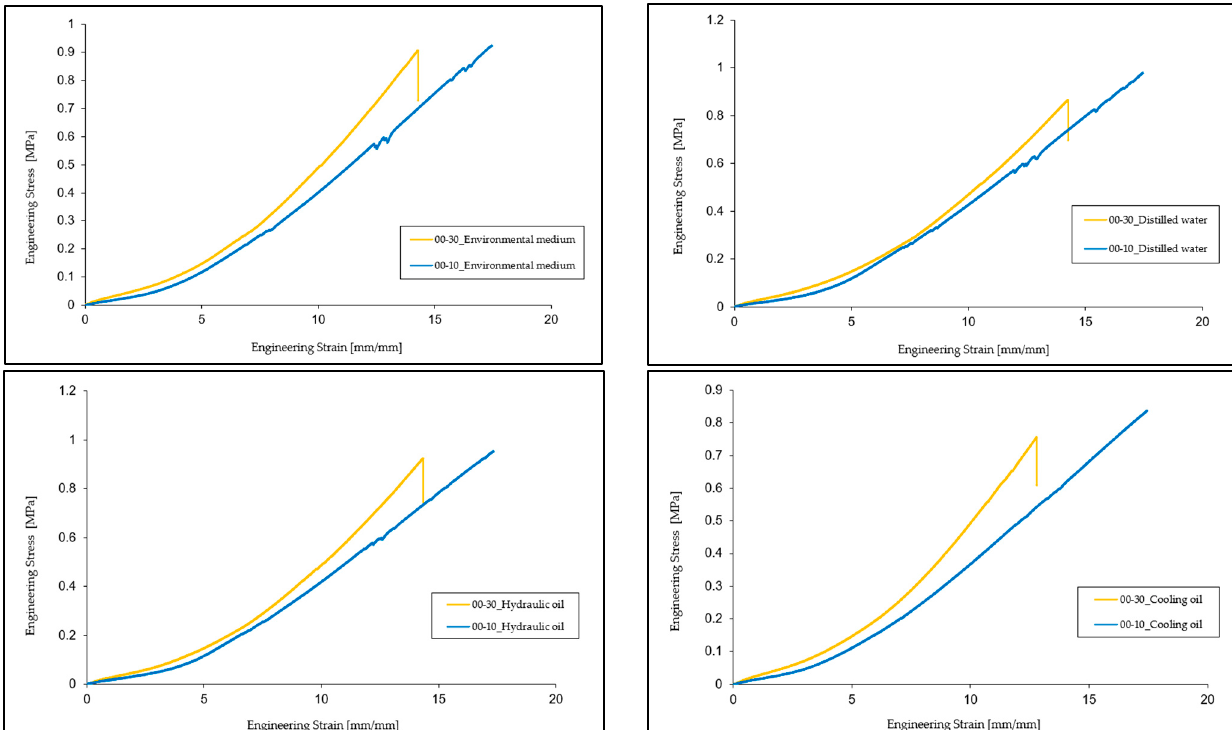
Figure 8. Comparative average of specimens 00-30 and 00-10 in ambient medium, distilled water, hydraulic oil, and cooling oil.